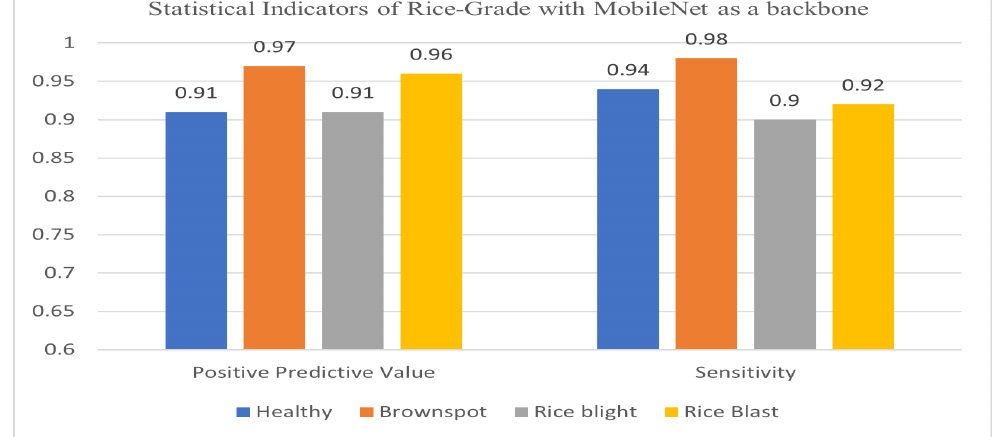
Figure 9. PPV, sensitivity, and DSC of proposed model using MobileNet backbone architecture.